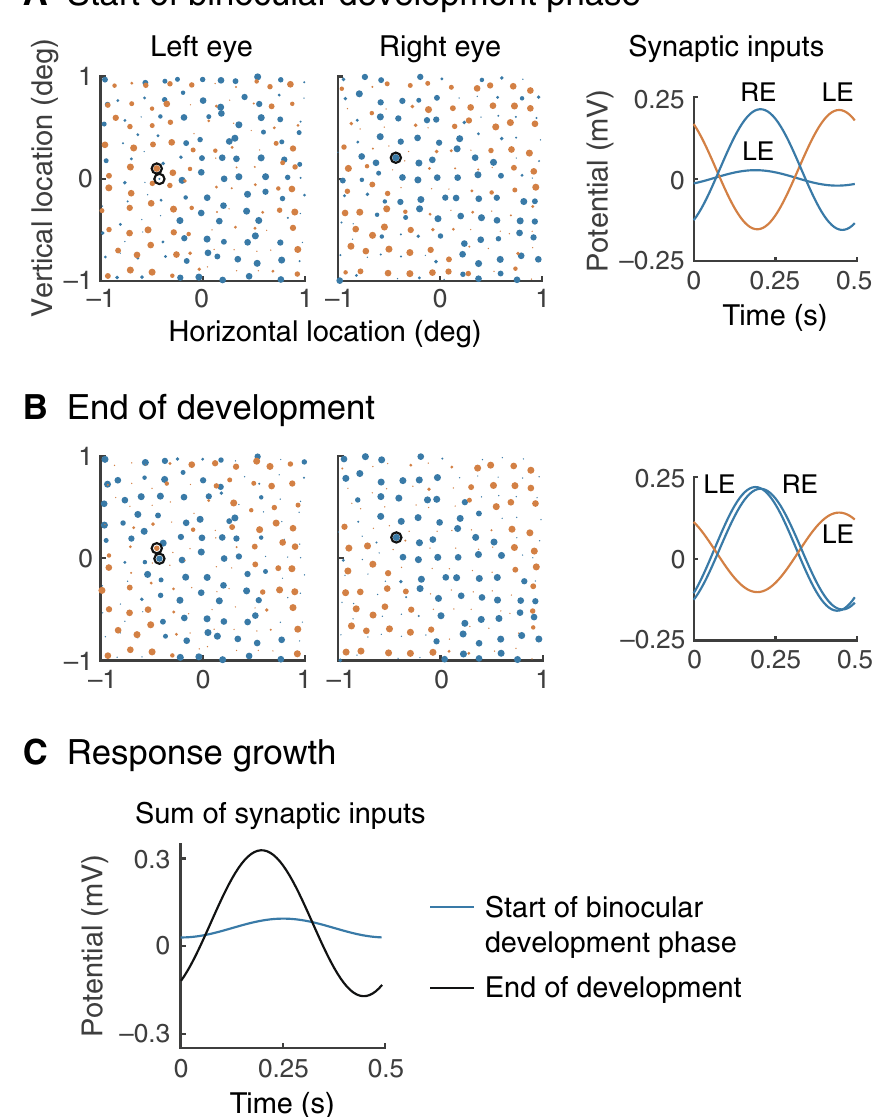
Figure 3. Mechanism of binocular congruence. ( A ) The visual field maps at left are expanded versions of Fig. 2B. Three subcortical inputs are highlighted by black circles. The graph at right shows the time course of these inputs in response to a drifting grating; LE and RE stand for left and right eye, respectively. There is destructive interference between the responses when added at the synapse with the cortical neuron. ( B ) Hebbian plasticity during the binocular phase of development up- and down-regulates the synaptic weights of circled left-eye off- and on-channels, respectively. ( C ) These synaptic changes improve the amplitude of the summed synaptic